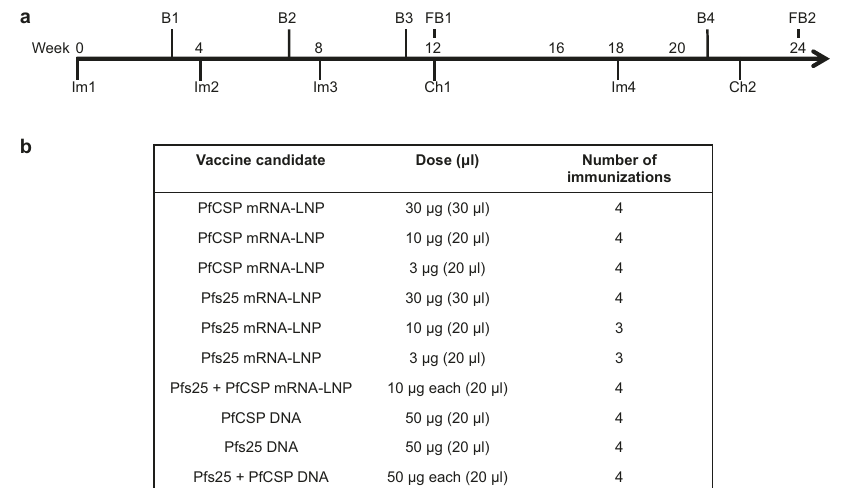
Fig. 1 Timelines for mRNA immunization experiment. a Groups of female Balb/c mice were immunized (Im) with 3 μ g, 10 μ g, and 30 μ g of mRNA-LNPs encoding either Pfs25 or PfCSP. Another group of mice received a combination of 10 μ g of both Pfs25 and PfCSP mRNA-LNPs. In parallel, mice were also immunized with 50 μ g of DNA plasmids encoding Pfs25 or PfCSP and a combination of 25 μ g of both Pfs25 and PfCSP DNA plasmids. Immunizations were repeated as indicated, and test bleeds (B1-B4) and fi nal bleeds (FB1 and FB2) were collected at indicated time points. Mice immunized with 3 μ g and 10 μ g Pfs25 mRNA-LNP were terminally bled at 12 weeks (FB1) while all other groups were terminally bled at 24 weeks (FB2). Mice immunized with PfCSP mRNA or DNA plasmids were challenged (Ch1 and Ch2) with sporozoites of PbPfCSP-GFPLuc to assess protection. 30 μ g Pfs25 mRNA-LNP and Pfs25 DNA immunized mice were used as a negative control for sporozoite challenge experiments. b Table of immunization parameters corresponding to timeline in ( a